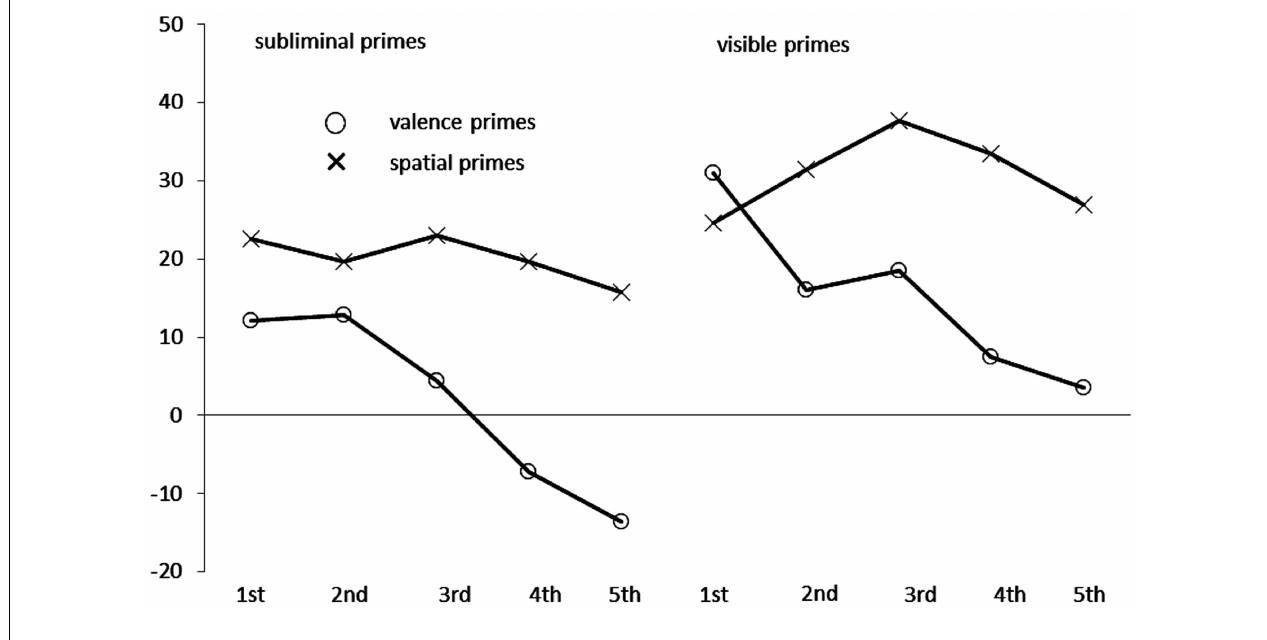
FIGURE 2 | Mean congruence effects in milliseconds, calculated as mean correct ReactionTimes (RTs in ms) of incongruent conditions minus mean correct RTs of congruent conditions in Experiment 1, as a function